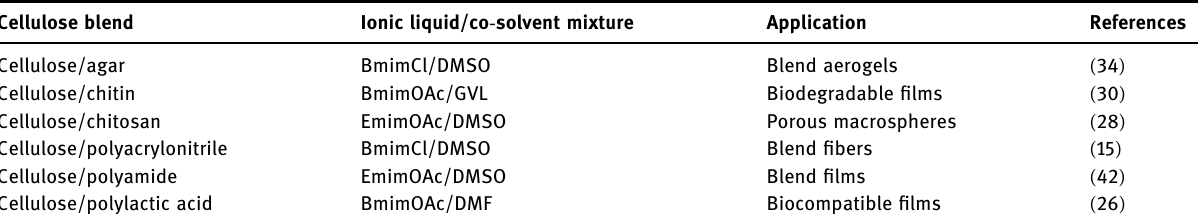
Table 10: Examples of applications of cellulose blends regenerated from cellulose blend/imidazolium - based ionic liquid/co - solvent solutions Cellulose